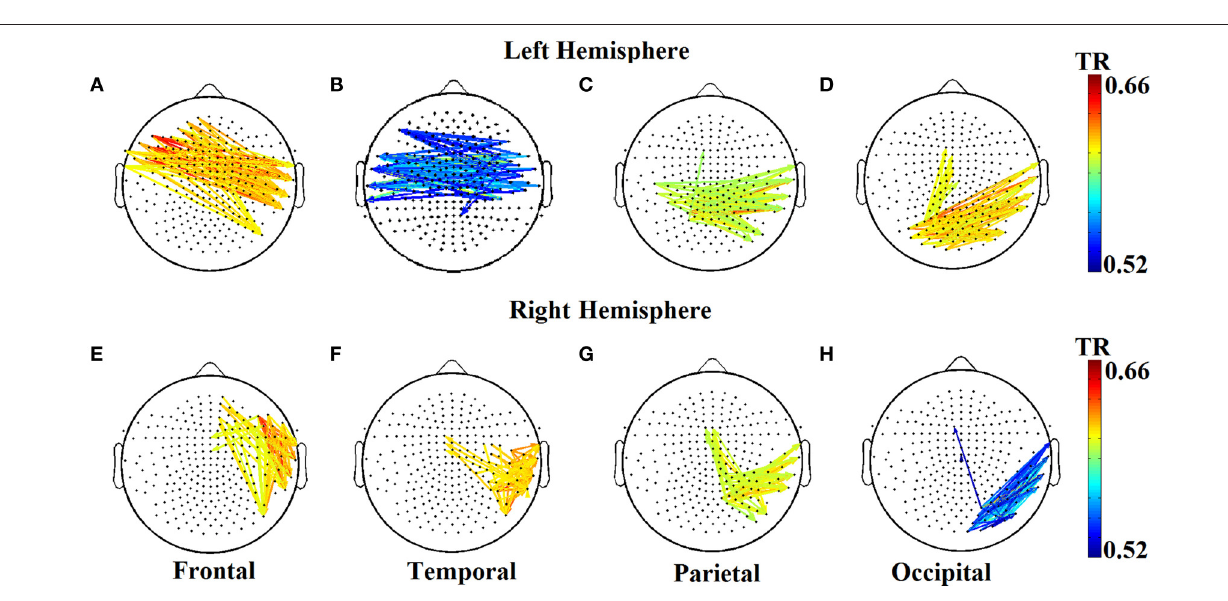
FIGURE 5 | Group-averaged transition rate (TR) for pairs of sensors located roughly over the four lobes (A–D and E–H) in each hemisphere for RD children. For better visualization results were thresholded based on mean + 2SD from the set of 248 × 248 TR values in order to reveal the most significant TRs over the entire sensor space. Corresponding TR values failed to reach significance in the NI group (not